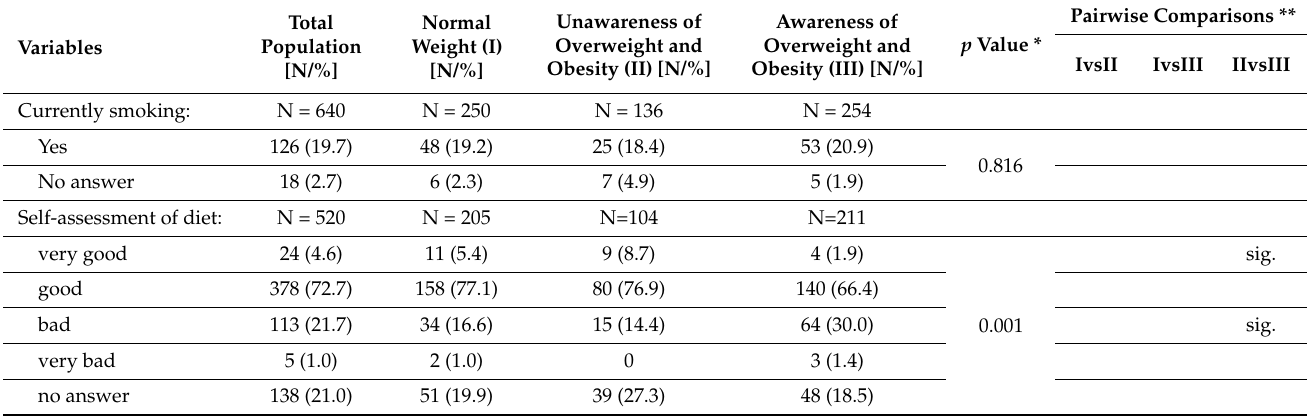
Table 6. The selected lifestyle elements of the study population.